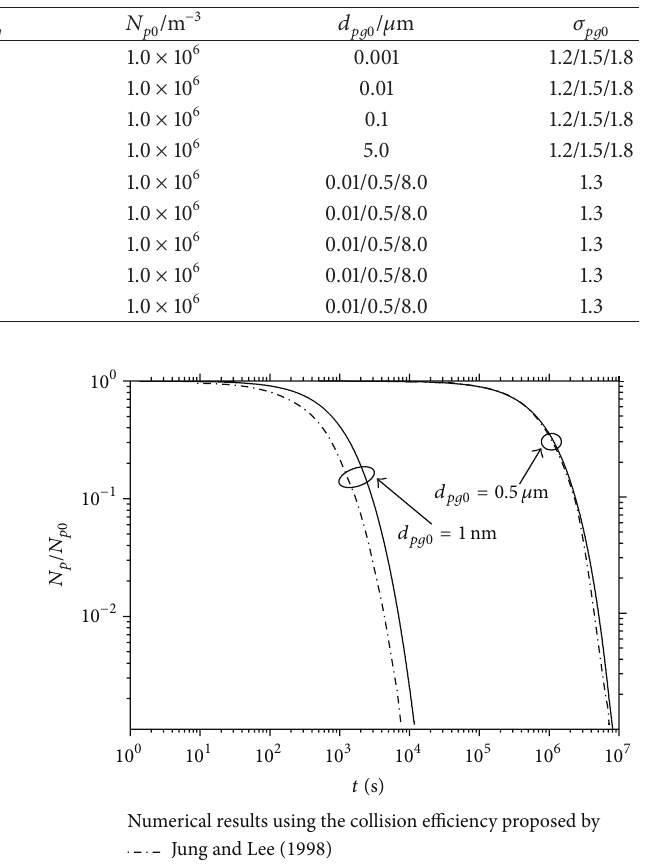
Table 1: The values of the initialization parameter for Cases 1–9.